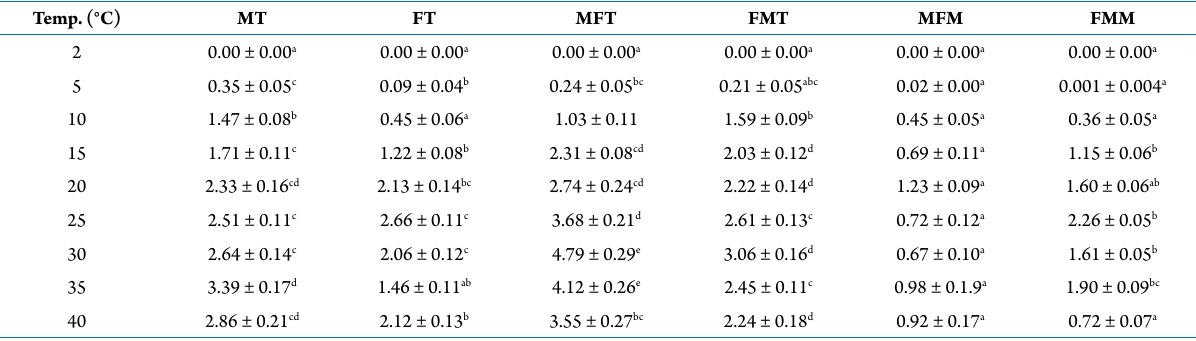
Values with the same superscripts in the same row are not significantly different at the 5 %